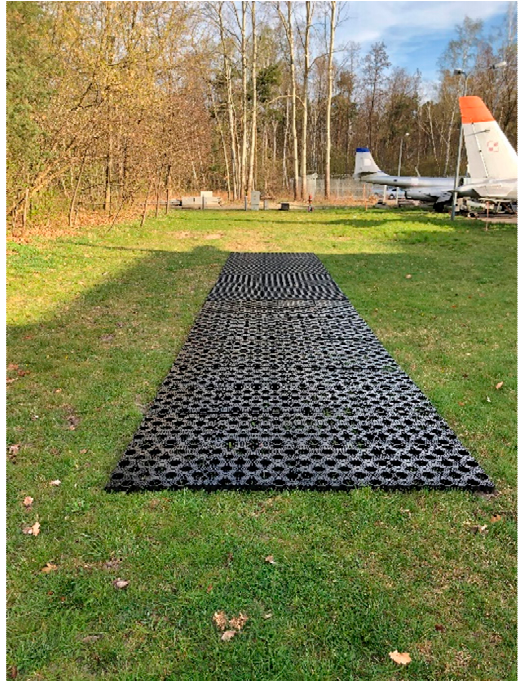
Figure 18. Airfield geocell ready to be pressed into the pavement.